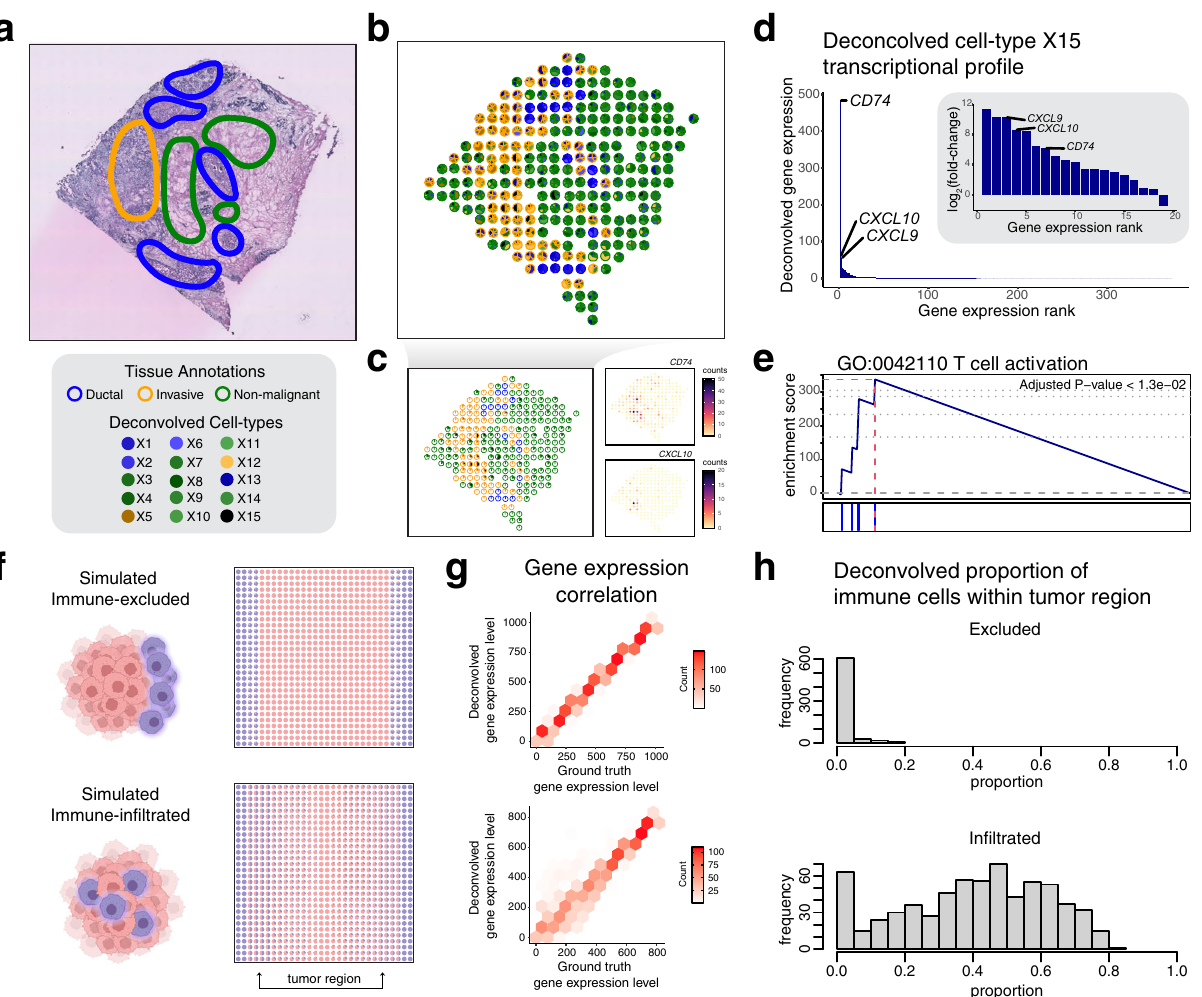
Fig. 5 STdeconvolve characterizes the spatial organization of immune cells in real and simulated breast cancer ST data. a An H&E-stained image of the breast cancer tissue with pathological annotations adapted from Yoosuf et al. 30 . b Deconvolved cell-type pixel proportions for ST data of a breast cancer tissue section, represented as pie charts. Pixels are outlined with colors based on the pixel transcriptional cluster assignment corresponding to 3 pathological annotations. c Highlight of deconvolved cell-type X15. Pixel proportion of deconvolved cell-type X15 are indicated as black slices in pie charts. Pixels are outlined with colors as in ( b ). Select genes corresponding cell-type X15 ’ s select top marker genes are shown. d Barplot of the deconvolved transcriptional pro fi le of cell-type X15 ordered by magnitude. Inset represents the log 2 fold-change of the deconvolved transcriptional pro fi le of cell-type X15 with respect to the mean expression of the other 14 deconvolved cell-type transcriptional pro fi les. Select highly expressed and high fold-change genes are labeled. e Gene set enrichment plot for signi fi cantly enriched GO term “ T cell activation ” for deconvolved cell-type X15. f Simulated ST datasets of an immune-excluded tumor sample (top) and immune-in fi ltrated tumor sample (bottom) using mixtures of single cells represented as pie charts for each simulated ST pixel. g Deconvolution results for the simulated ST data by STdeconvolve. The ranking of each gene based on its expression level in the deconvolved-cell-type transcriptional pro fi les compared to its gene rank in the matched ground truth cell-type transcriptional pro fi les for the simulated immune-excluded tumor sample (top) and immune-in fi ltrated tumor sample (bottom). h Histogram of the deconvolved proportion of immune cells in the tumor region de fi ned in ( f ) for the simulated immune-excluded tumor sample (top) and immune-in fi ltrated tumor sample